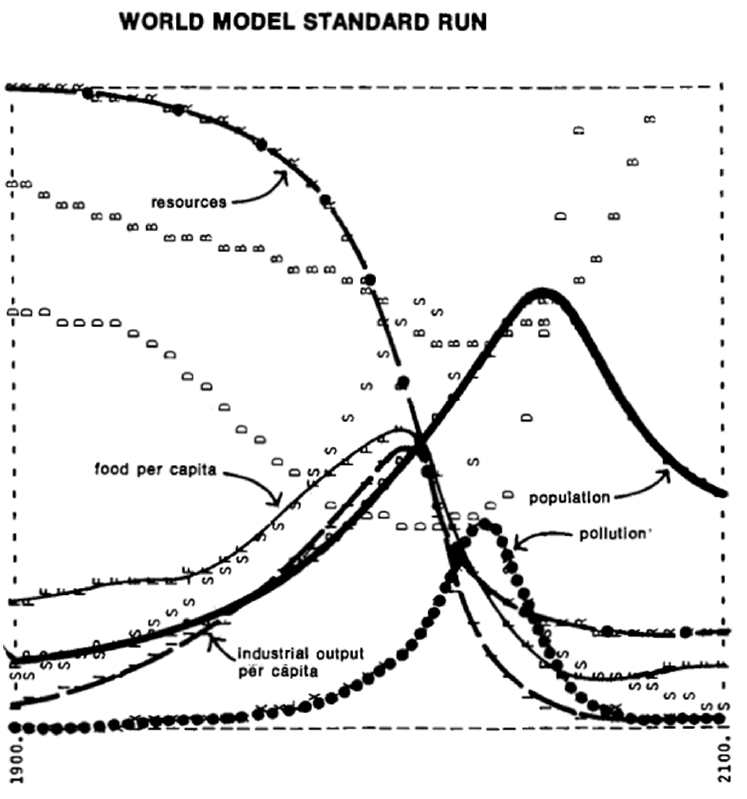
Figure 1. The “Standard model” output for the original Limits to Growth study [3]. Events of that time and shortly after seemed consistent with the conclusions of the LTG model. Long lines at gasoline stations during the “energy crises” of the 1970s and severe economic events, including “stagflation”, as well as a series of quite pessimistic books and reports about the future came out (or had come out) by ecologists Ehrlich and Harden and naturalist Carson. Many additional reports in scientific journals all seemed to give credibility to the point of view that our population and our economy had in many ways exceeded the world’s “carrying capacity” for humans and their activities. The